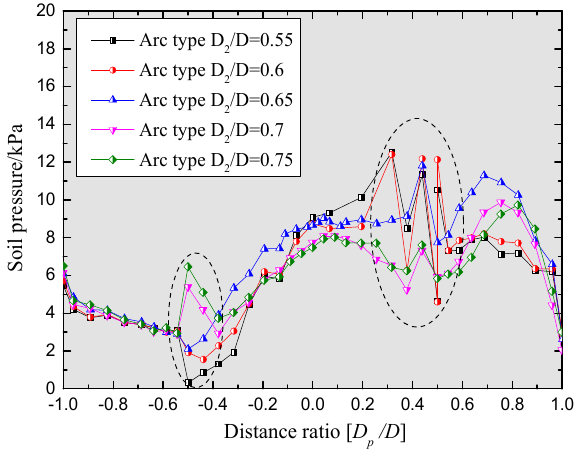
Figure 18. Soil pressure on the top cover.